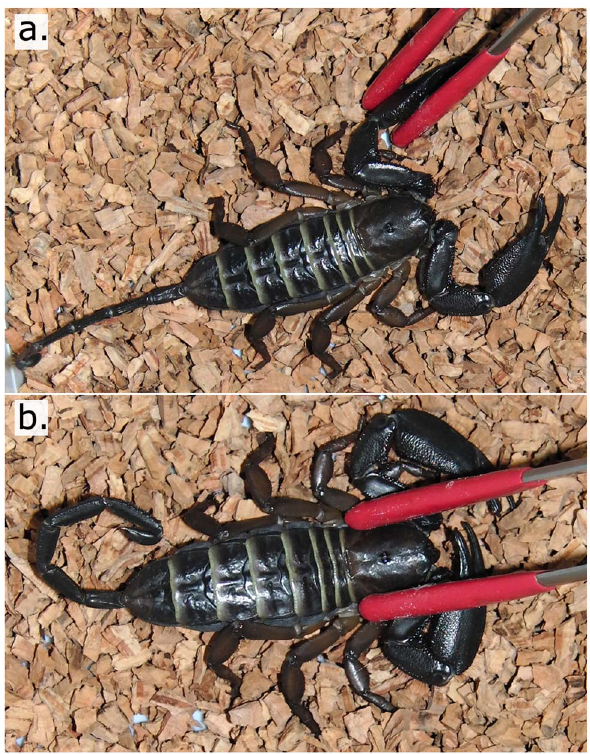
Figure 1. Defensive behavior trials, shown on a specimen of Hadogenes cf. paucidens . First each chela is pinned to the ground using rubber-tipped forceps for 5 seconds (a.). Subsequently, the prosoma is pinned down for 5 seconds (b.), and the defensive response categorized as using one or both chelae (1), the telson (2), chelae and telson (3) or neither